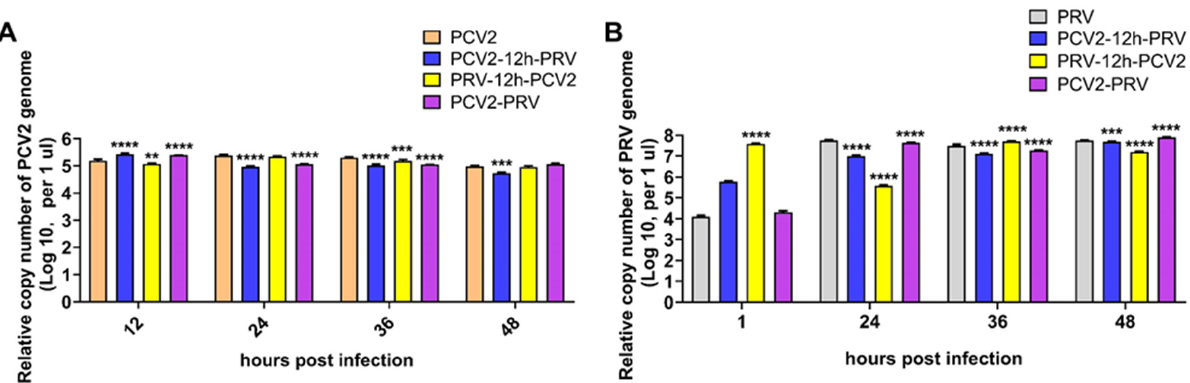
(Figure 1B). The growth curves of PRV in the coinfection groups (PCV2+PRV group, PRV- 12h-PCV2 group) were similar to that of the PRV single infection group.